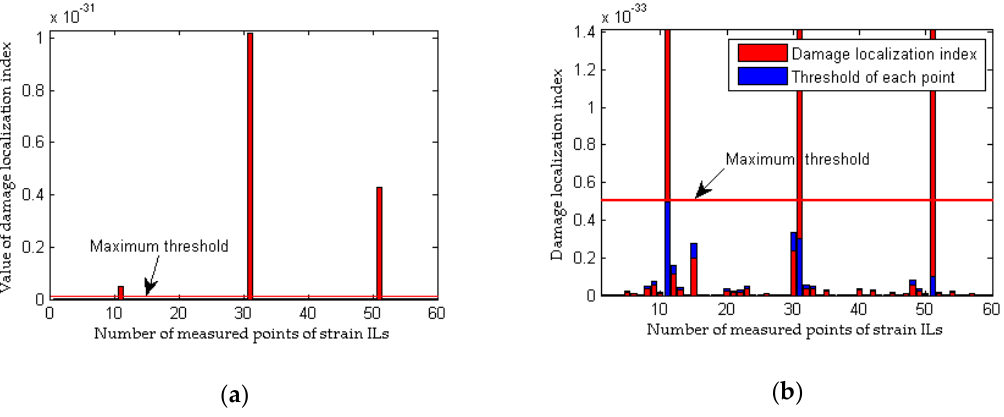
Figure 7. Results of the proposed method without the effects of measurement noise (for multiple damaged elements): ( a ) results of the proposed method for case 5; ( b ) detailed magnification of the results of the proposed method for case 5.